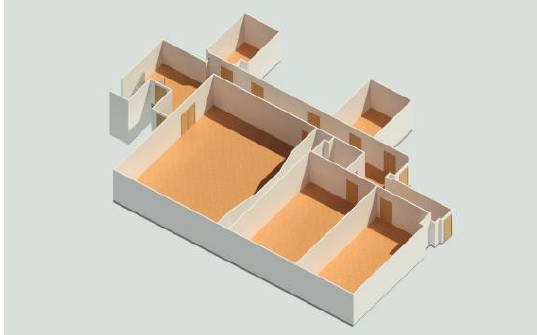
Figure 8. BIM model of the case study (Khoshelham, et al, 2017).